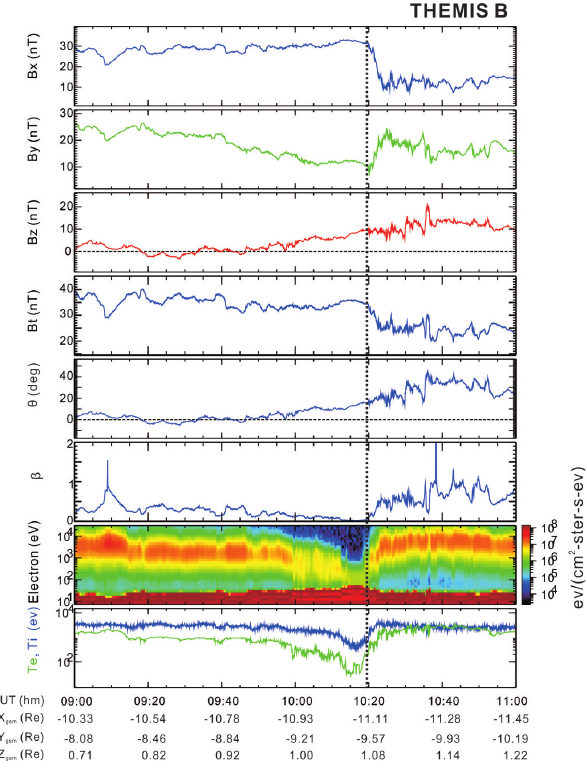
Fig. 6. Summary plots of THEMIS C’s observations between 09:00UT and 11:00UT on 5 December 2008: the three compo- nents of the magnetic field in GSM coordinate, the total magnetic field, plasma β , energy spectra of 0.005–300keV electrons from the Solid State Telescope (SST) and ESA instruments, and the ion and electron temperature.